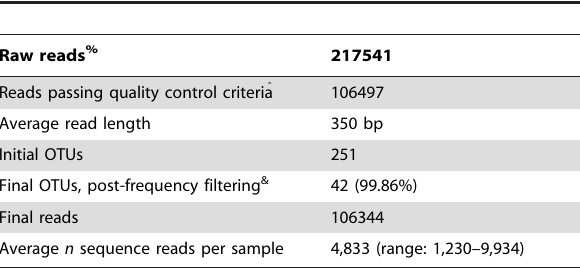
Table 2. Mattila et al. (2012) dataset pyrotag processing